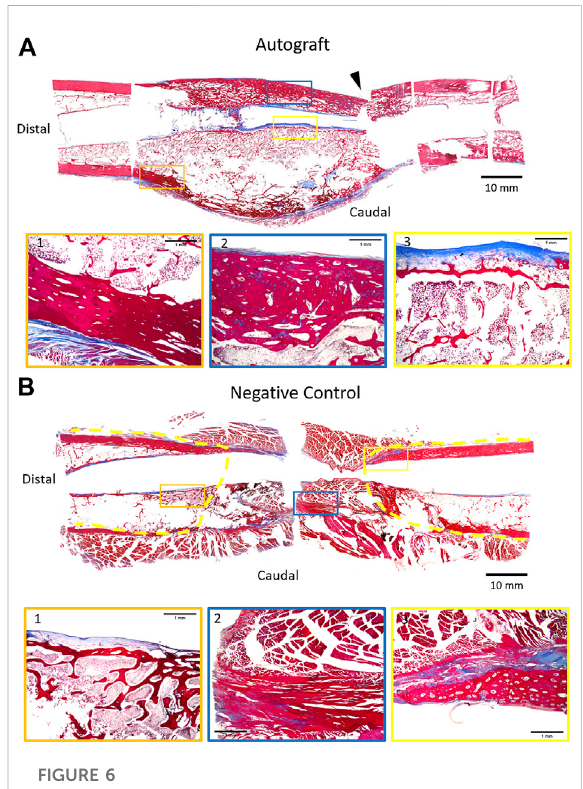
FIGURE 6 Representative histology of autograft and negative control at 18 weeks. Upon completion of mechanical testing (autograft), femurs were carefully removed from potting. AS-ILNs were removed and the fractured segments were temporarily stabilized with circumferential sutures. Samples were photographed, marked to document spatial orientation, and decalci fi ed. To provide a comprehensive histologic image of the 4 cm defect, specimens were sub-sectioned to fi t within jumbo cassettes and processed for histology. Sections were stained with Masson ’ s Trichrome, followed by scanning and digital reconstruction to generate a low magni fi cation digital mosaic. (A) Representative histology of femur treated with autograft. Arrowhead denotes location of mechanical testing failure point. The cortical region at mid-diaphysis is expanded by trabecular bone (Insets 1,2) admixed with fi brovascular connective tissue (Inset 3). (B) Representative histology of negative control femur. Dashed yellow lines denote extent of callus formation. In the negative control, the mid-shaft cortical region was devoid of trabecular bone and was fi lled by fi brovascular connective